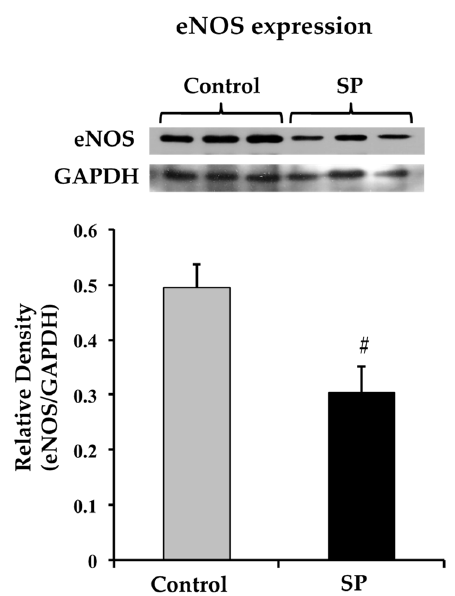
Figure 2. The eNOS expression in aortas from control and sucrose period rats (SP). Data represent mean ± SEM, # p < 0.05, n = 4 (4 different homogenates from pools of 3 aortas from different rat pups and litters). A representative Western blot analysis is shown above the graph.